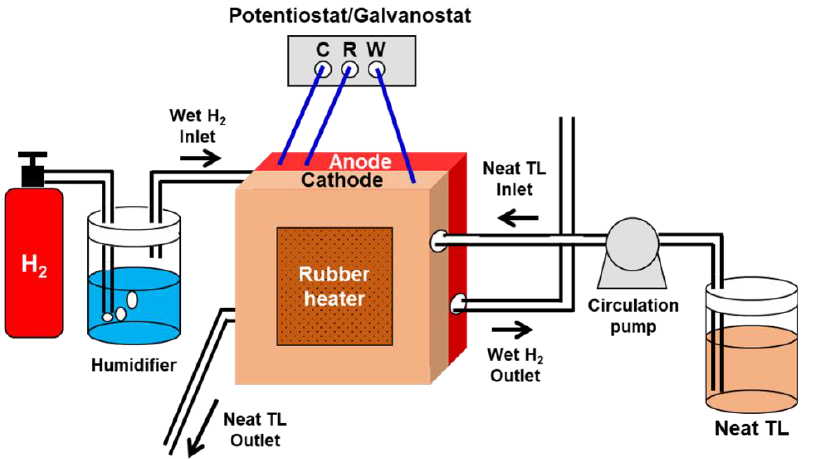
Figure 7. A schematic diagram of electrochemical hydrogen pump TL hydrogenation